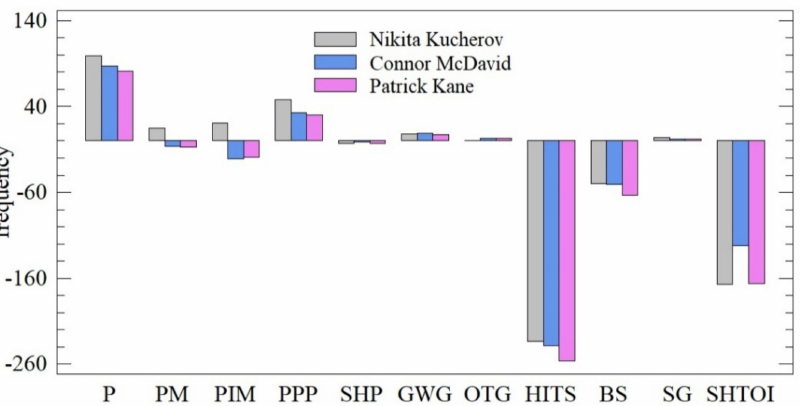
Figure 9. Comparison with the best player as evaluated by the SD–TOPSIS combination (Brandon Tanev).